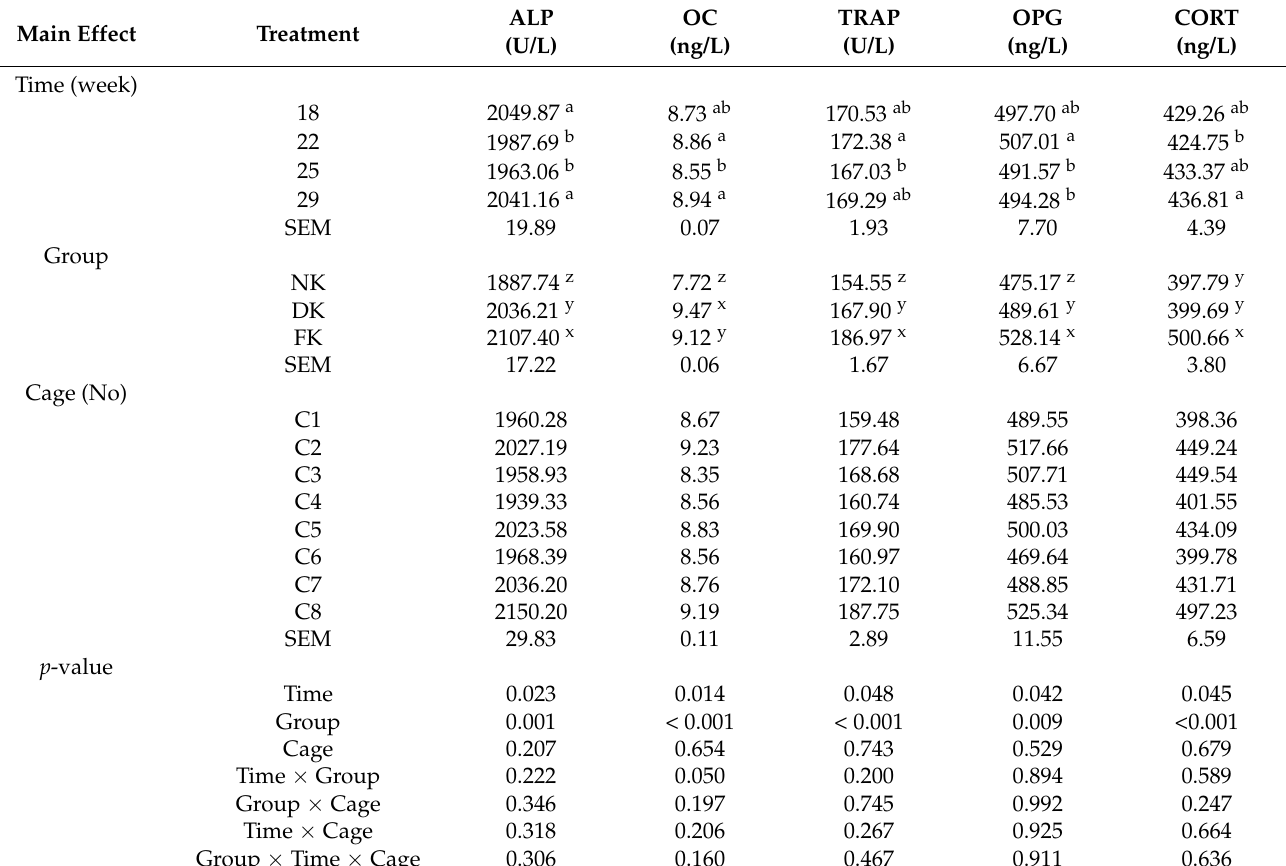
Table 5. Measurement of serum bone metabolism and remodeling-related markers in laying